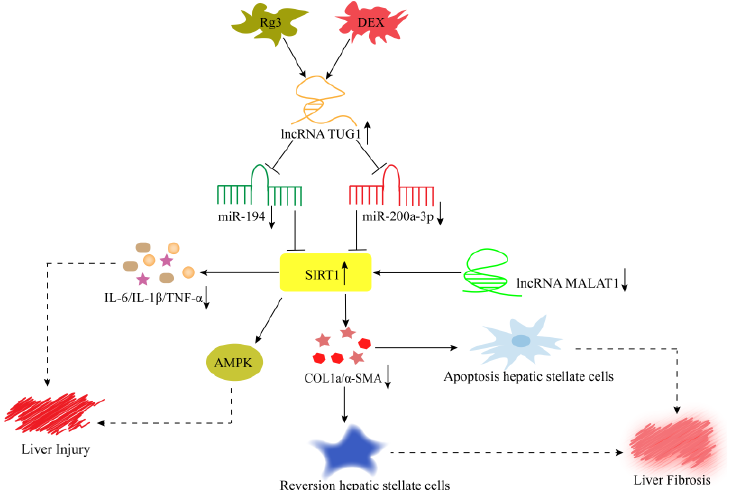
Figure 5. Mechanism of lncRNAs in hepatic inflammatory diseases. DEX suppresses the inflammatory response of hepatocytes by mediating of lncRNA TUG1/miR-194/SIRT1 axis. Rg3 increases the expression of lncRNA TUG1 and reduces the expression of miR-200a-3p to stimulate the SIRT1/AMPK pathway, thus improving liver injury. SIRT1 is involved in the development of liver fibrosis through the regulation of lncRNA MALAT1.